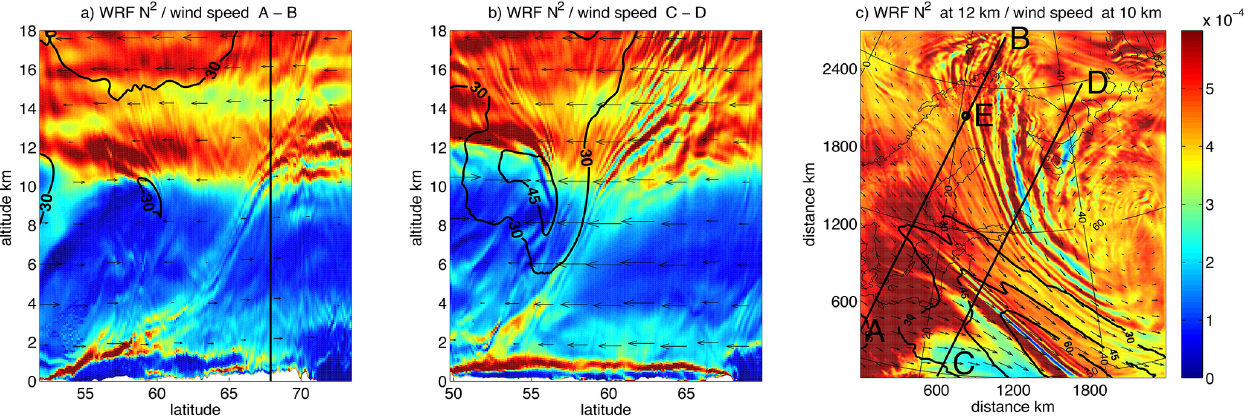
Figure 6. Results from the WRF model as in Fig. 5, but for 00:00 UTC on 22 February